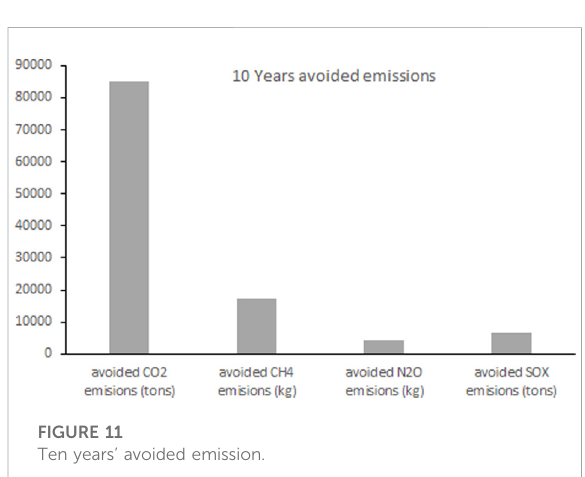
FIGURE 10 Avoided SOx emission.